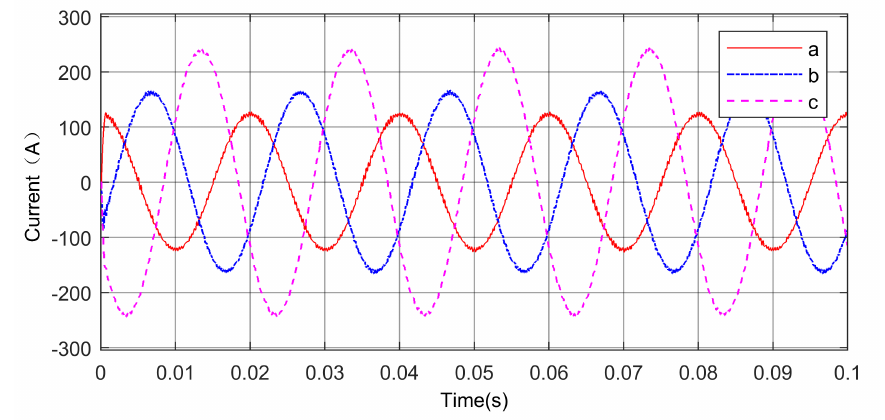
Figure 11. Output three-phase current diagram under case 2.